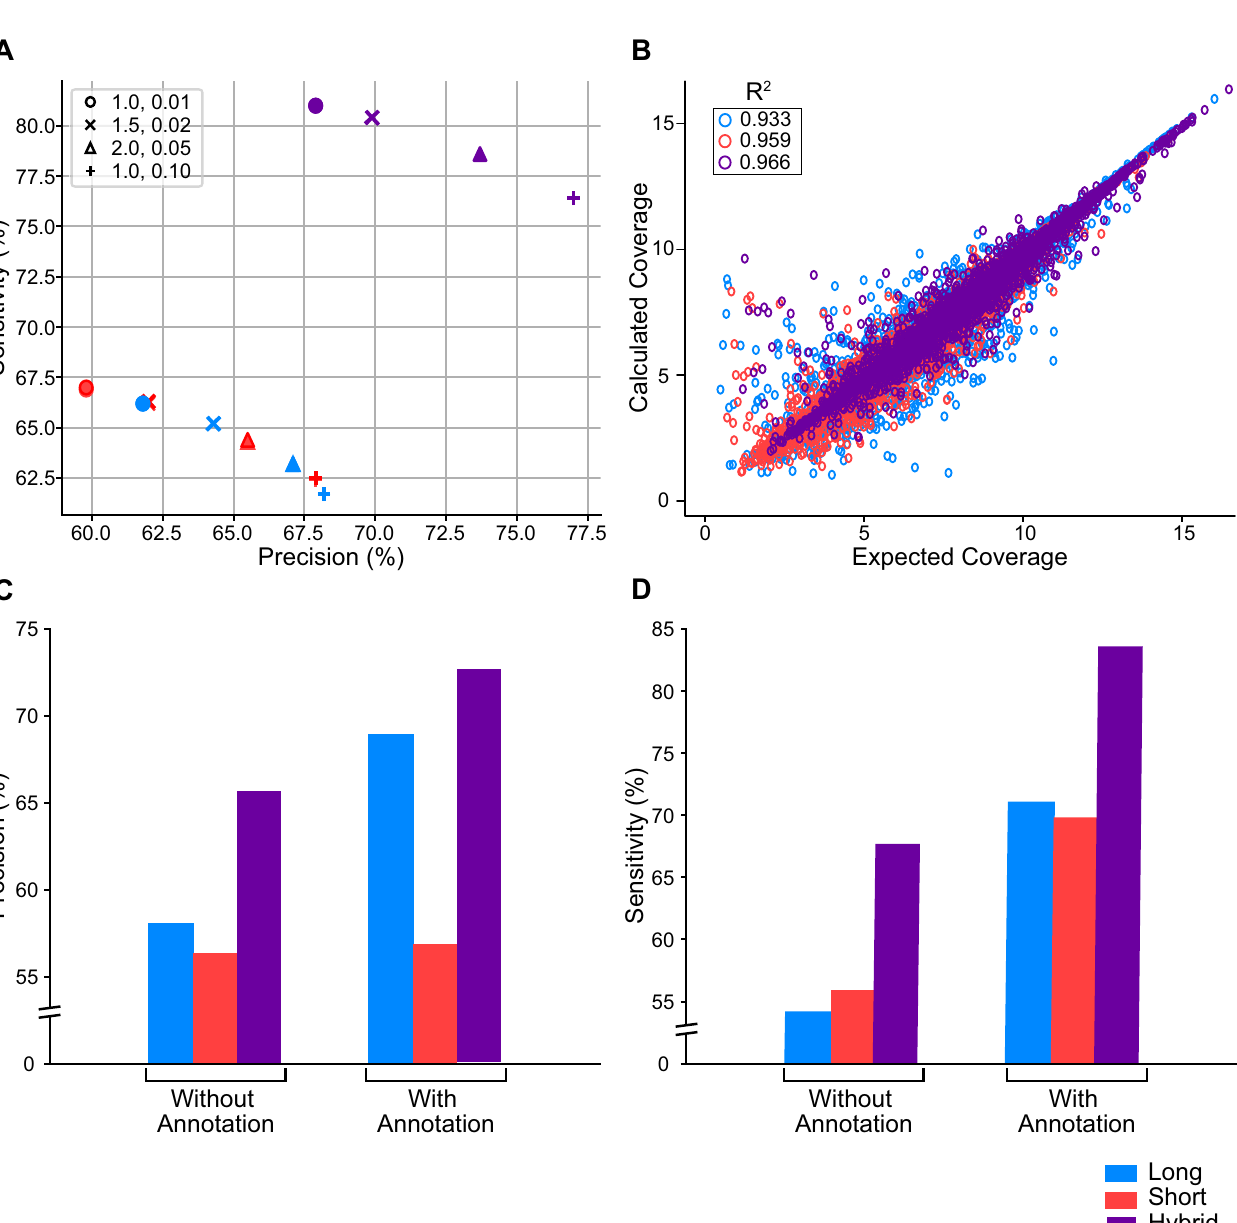
Fig 2. A) Sensitivity and precision for StringTie assemblies of simulated data with varying sensitivity parameters. The two StringTie parameters varied were the minimum read coverage allowed for a transcript (-c) and the minimum isoform abundance as a fraction of the most abundant transcript at a given locus (-f). Each shape represents a different combination of -c,-f parameters with the values indicated in the legend. The default values of -c and -f are 1.0 and 0.01 respectively and are represented by the circle marker. B) Calculated coverage vs. expected coverage for long-read, short-read, and hybrid-read assemblies of simulated data. Coverage values are normalized to log 2 (1 + coverage). C) Precision of long-read, short-read, and hybrid-read assemblies of simulated data with and without guide annotation. D) Sensitivity of long-read, short-read, and hybrid-read assemblies of simulated data with and without guide